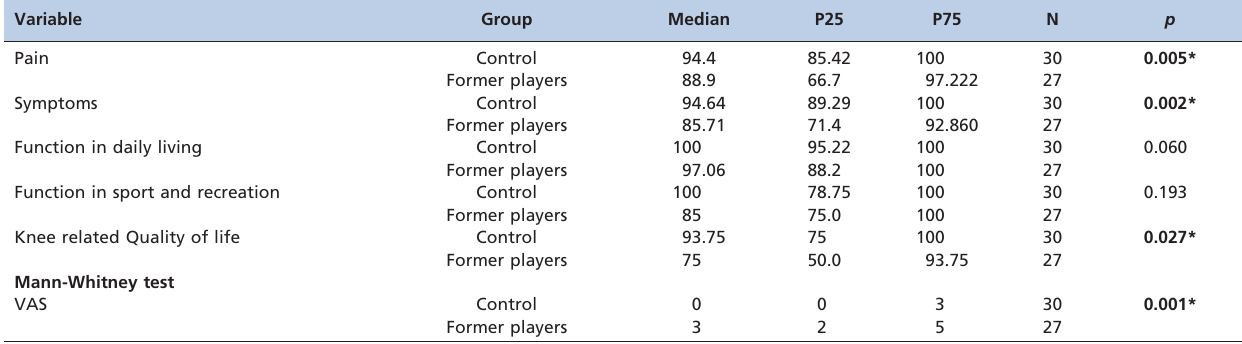
Table 5 - KOOS subscales and VAS comparison between groups. Variable Group